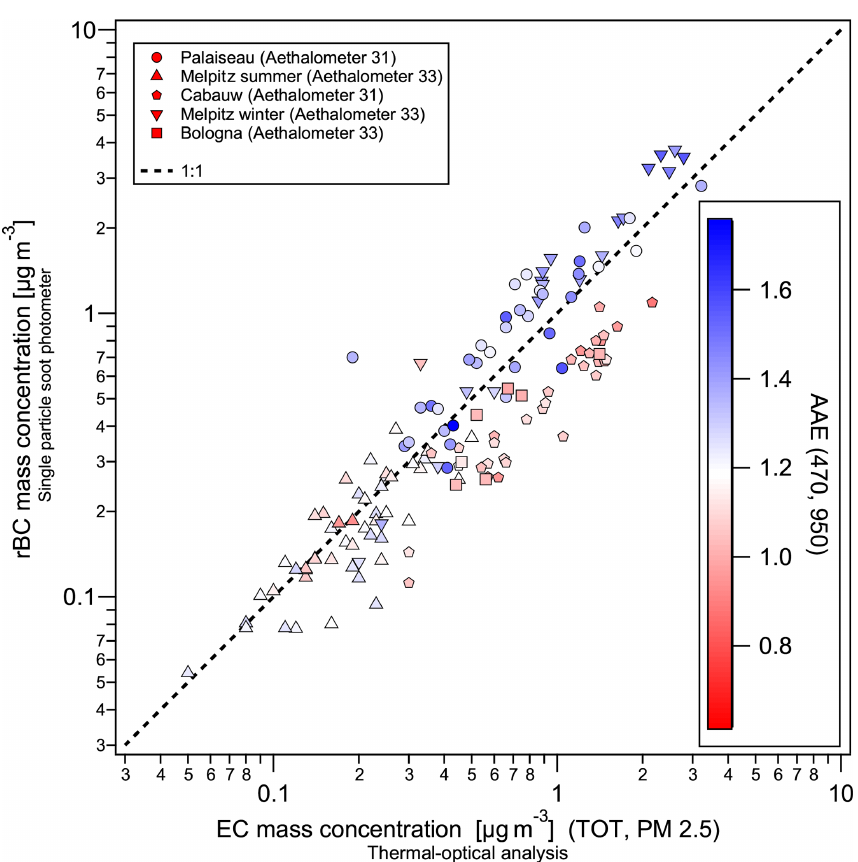
Figure 5. The rBC mass concentration versus EC mass concentration for all campaigns of this study color-coded by the Ångström absorption exponent of each data